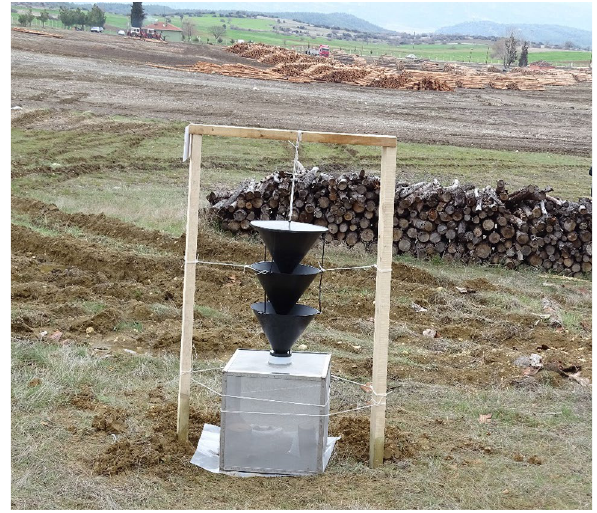
Figure 2. Insect collecting cage system integrated into Scandinavian type three funnel traps.